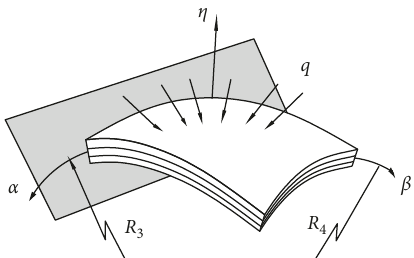
Figure 3: Model of the MFC thin